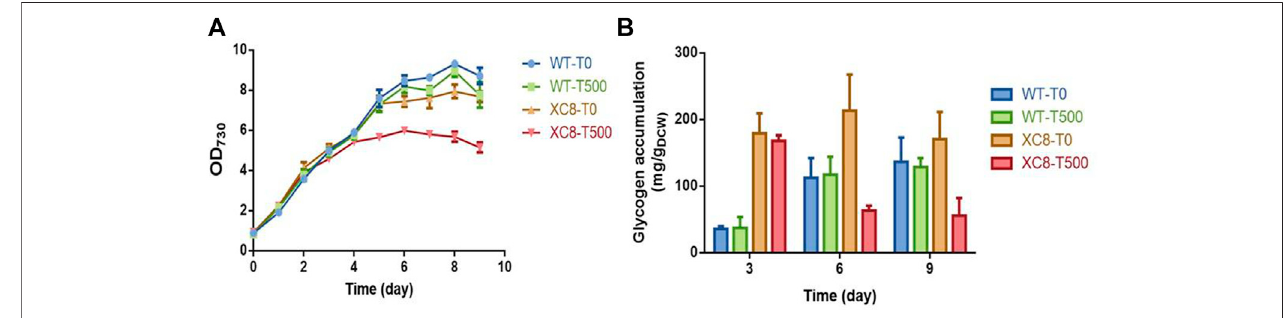
FIGURE 3 | Effects of theophylline-regulated glgP expression on PCC 7942 cell growths and glycogen contents in column photobioreactors. (A) Cell growth and (B) glycogen contents of the wildtype and XC8 strains when cultivated in column bioreactors. The cultivation would be bubbled with CO 2 (3% in air) and supplied